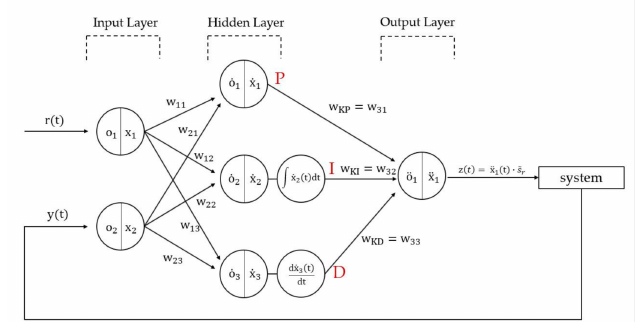
Figure 7. Structure of the Proportional-Integral-Differential Neural Network (PIDNN)